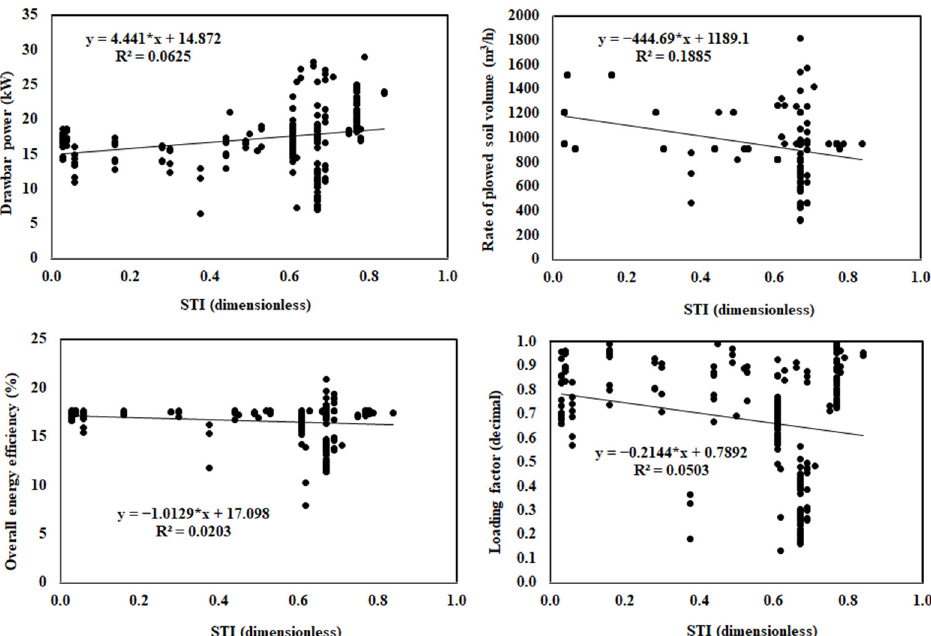
Figure 4. The correlation between the soil texture index (STI) and the performance attributes of overall energy efficiency, rate of plowed soil volume, drawbar power, and loading factor during soil tillage operation.